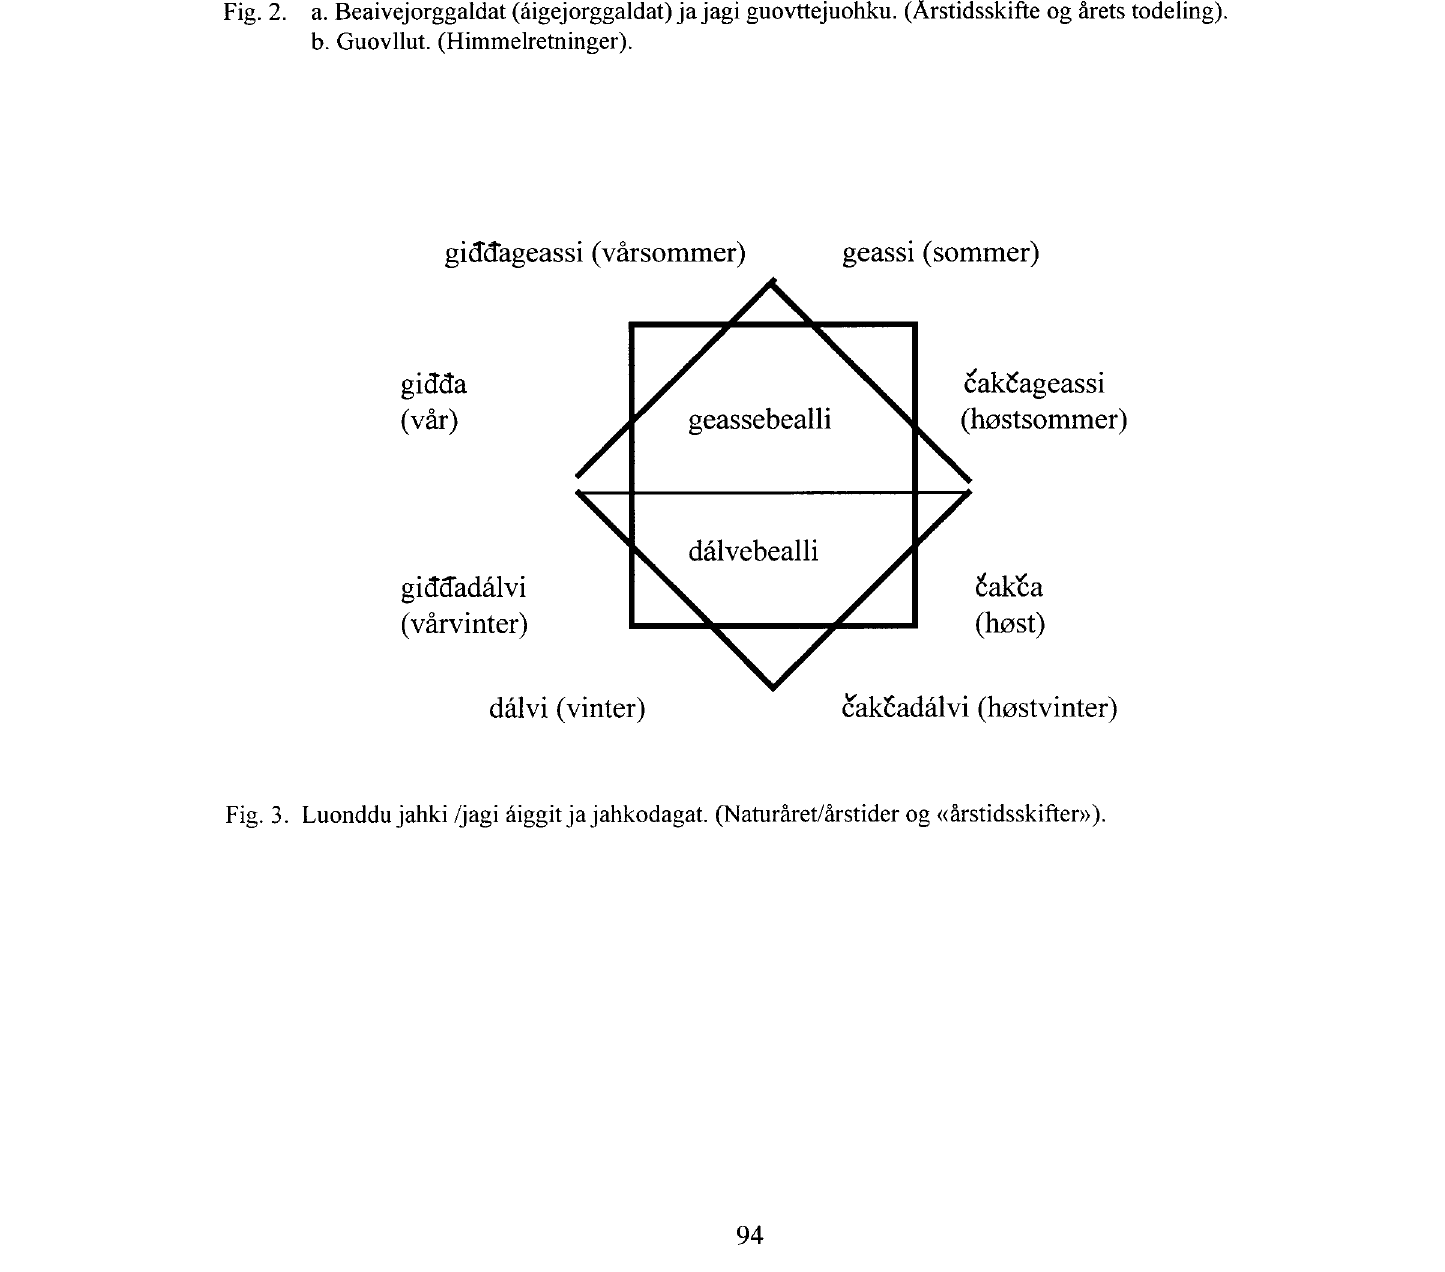
Fig. 2. a. Beaivejorggaldat (åigejorggaldat) ja jagi guovttejuohku. (Årstidsskifte og årets todeling), b. Guovllut. (Himmelretninger).